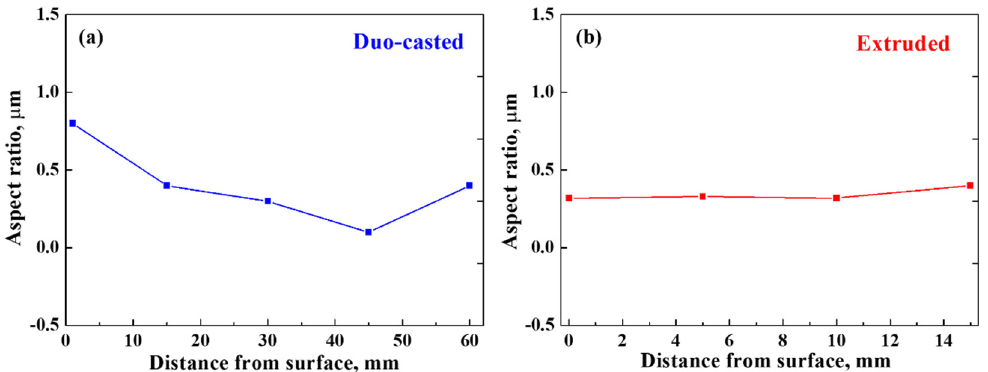
Figure 8. Distribution of aspect ratio of dendrites for ( a ) duo-casted and ( b ) extruded Al3003 / Al4004 clad material.